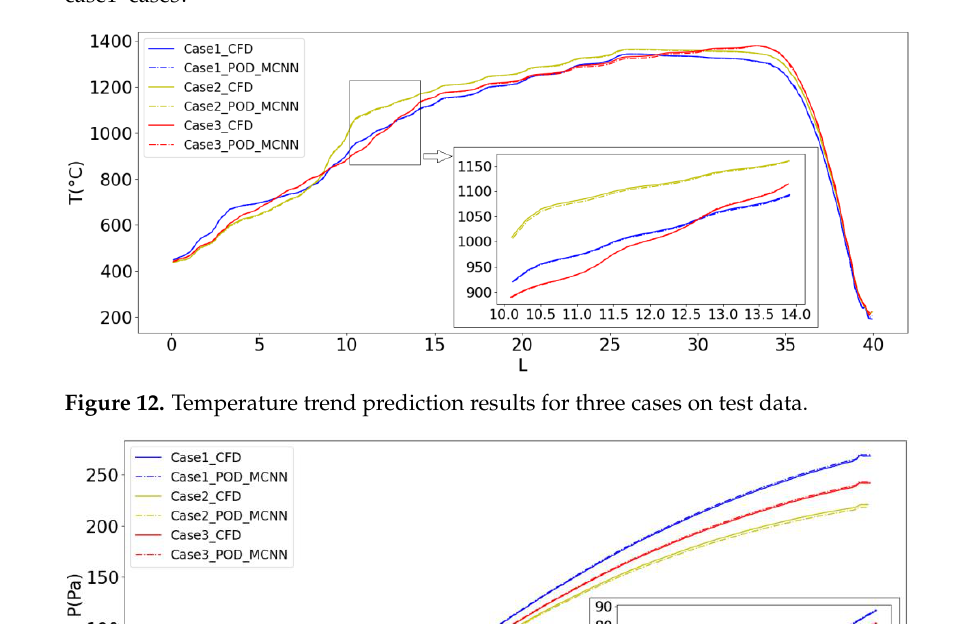
Figure 11. Temperature and pressure field prediction results for three cases at Z=350 mm. ( a – c ) is the temperature field prediction result of case1 – case3, and ( d – f ) is the pressure field prediction result of case1 – case3.